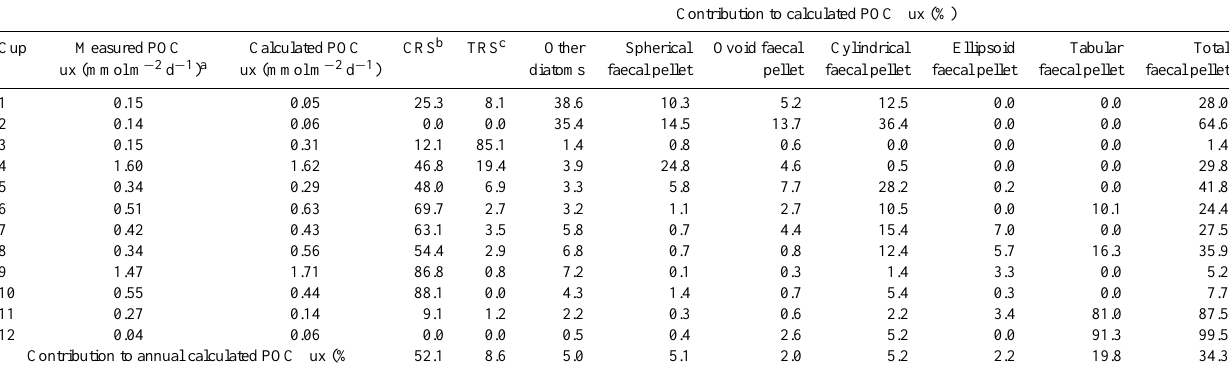
Table 7. Measured and calculated POC fluxes as well as POC flux partitioning among the major identified ecological vectors of carbon exported out of the mixed layer at station A3.